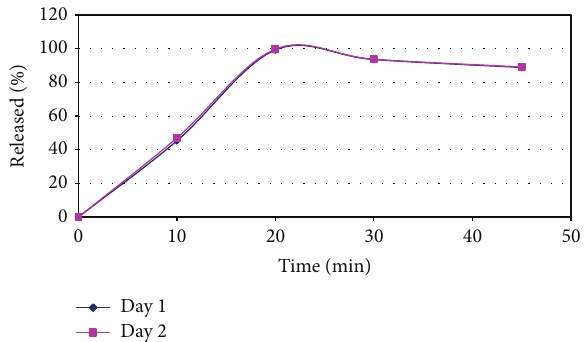
Figure 5: Dissolution profile of AcipHex DR tablets in tris buffer